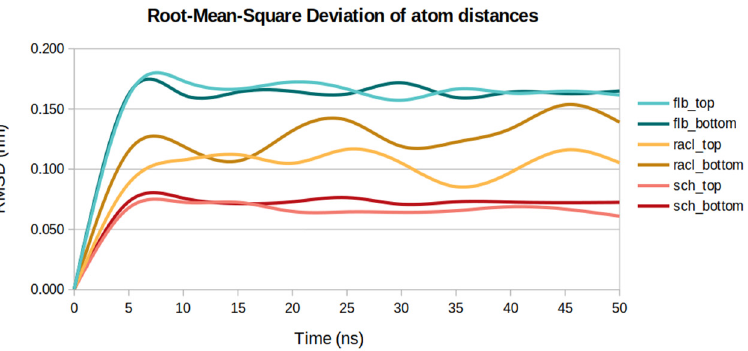
Figure 7. Atom-pair distances for the three ligands docked at the top and bottom parts of D2DR. The lowest atom-pair distances among all the ligands for both D2DR docked positions were observed for the SCH ligand, with an average atom distance value of 0.06 nm for the top part of the receptor and 0.07 nm for the bottom part of the receptor. Additionally, the atom-pair distance values for SCH are strongly correlated to the ligand’s RMSF average value of 0.068 nm and its lower gyration profile at both receptor positions of approximately 0.34